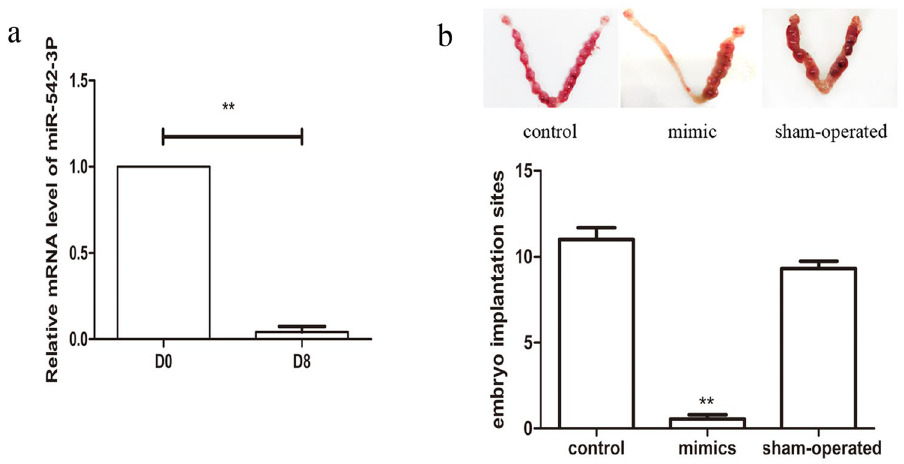
Figure 6. Relative mRNA level of miR-542-3p in early pregnancy and the effect of miR-542-3p overexpression on decidualization in mice uterus. ( a ) The mRNA level of miR-542-3p was analyzed by q-PCR on gestation D1 and D8. ( b ) Images showing embryo implantation sites on gestation D8 after injecting with miR-542-3p mimics unilaterally at the uterine horns or sham groups. Significant fold changes are marked by **p < 0.05 vs. D1. Values are expressed as mean ± SD, n =